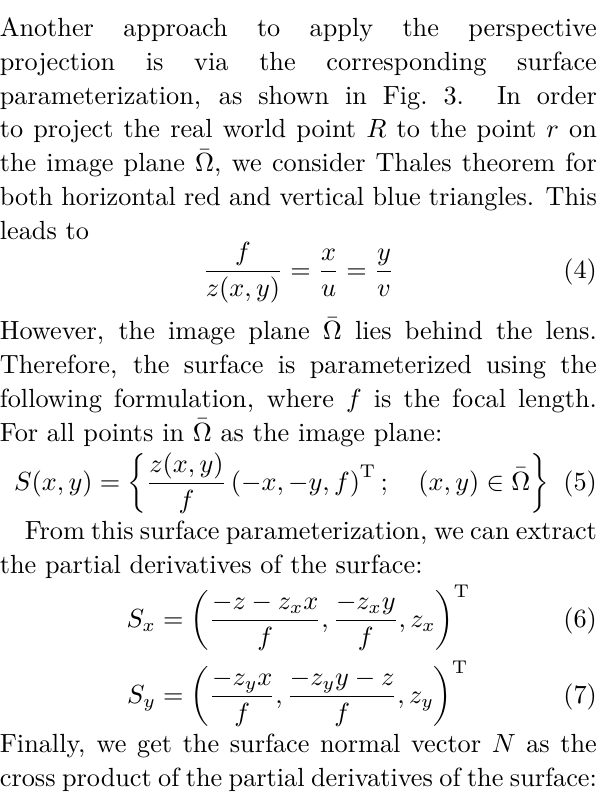
Algorithm 1 Transforming an orthographic normal